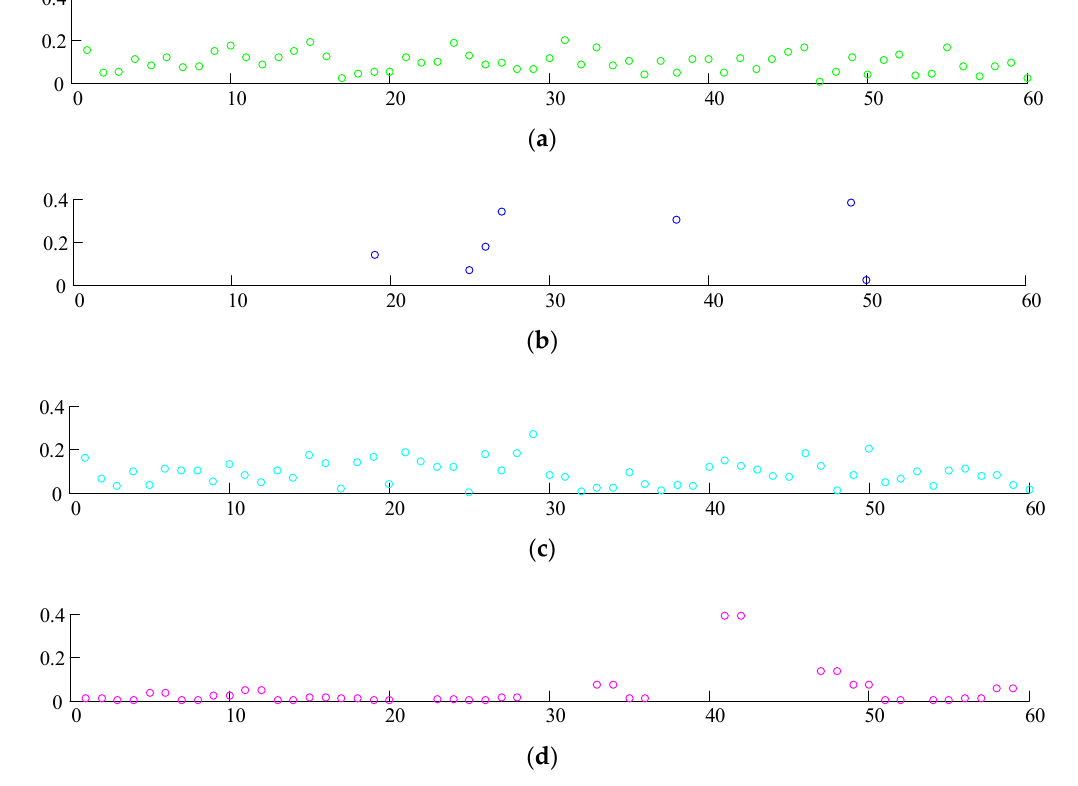
Figure 6. The sparse coefficient of each dictionary. ( a ) FFT coefficients; ( b ) Haar coefficients; ( c ) DCT coefficients; ( d ) DMD coefficients.